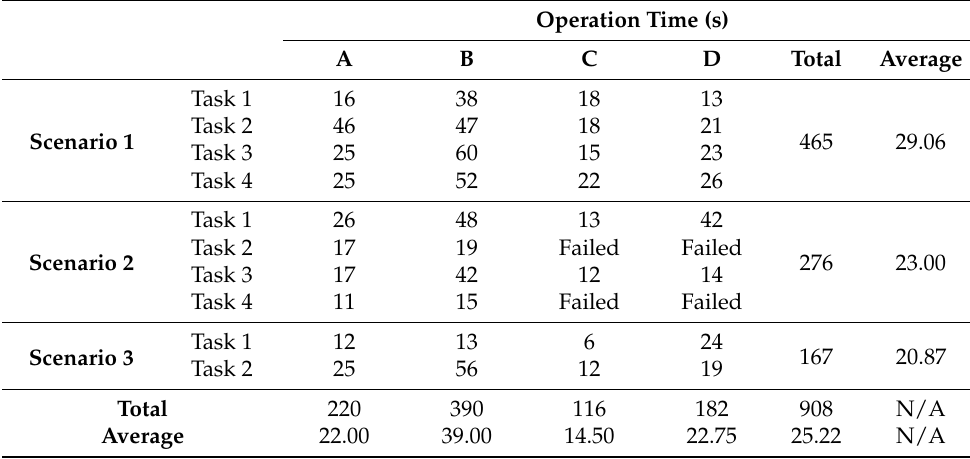
Table 6. Field test results for Method 1.